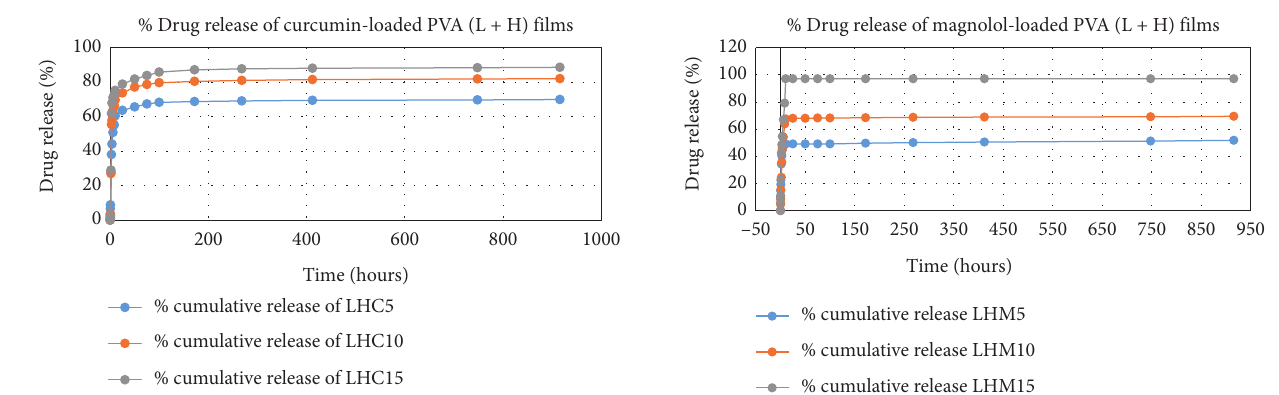
Figure 13: Drug release % of magnolol-loaded PVA (H+L) films.